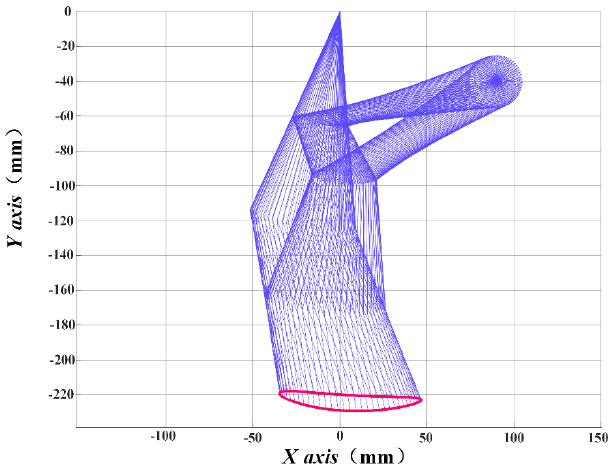
Figure 5. Track of each member and the foot end.